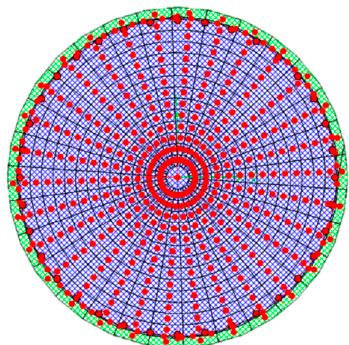
Figure 7. Sectional mesh of pier in this study.